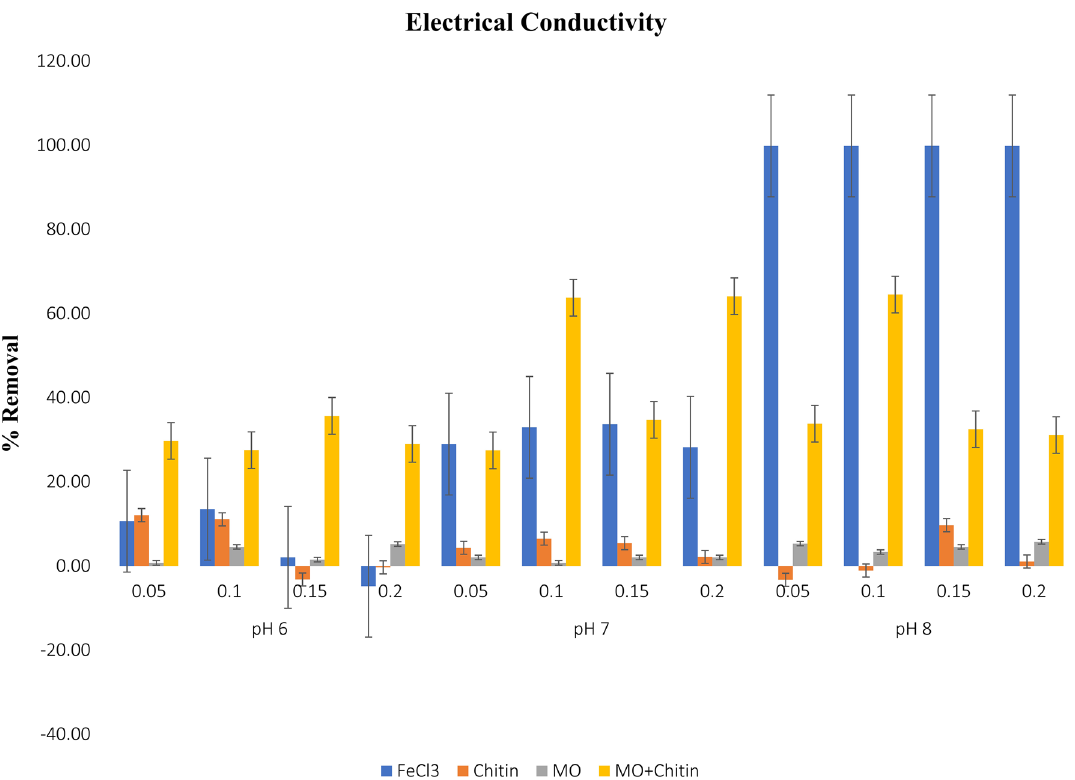
Fig. 2 Electrical conductivity reduction by the